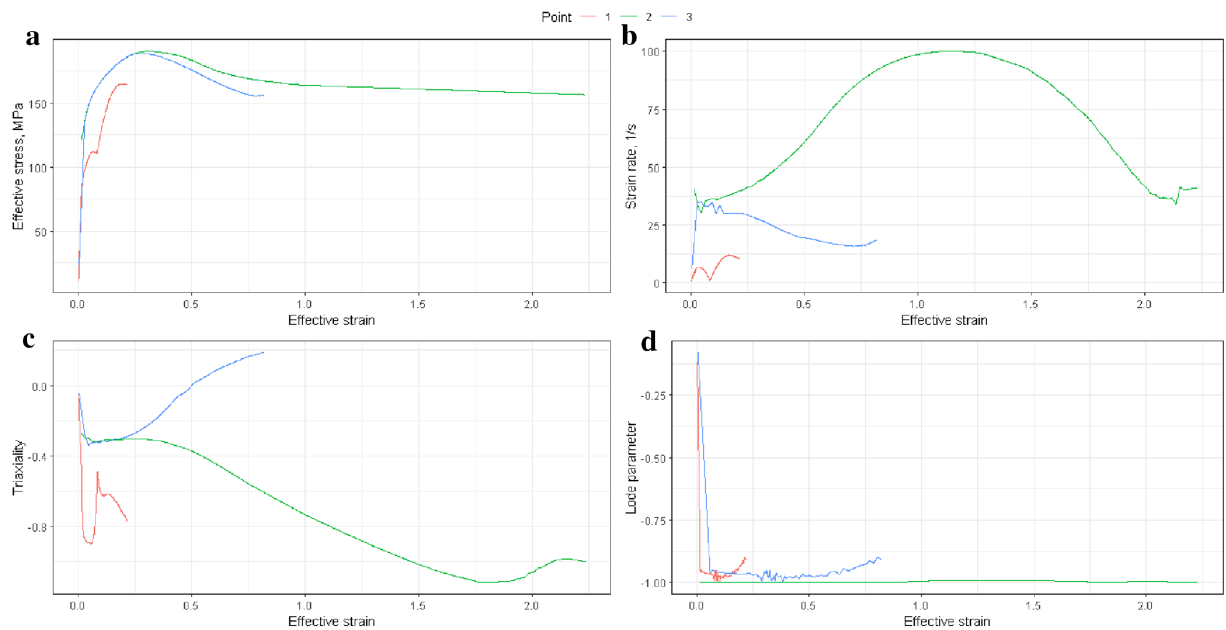
Fig. 15 Stress, strain rate, triaxiality, and Lode parameter for tracked